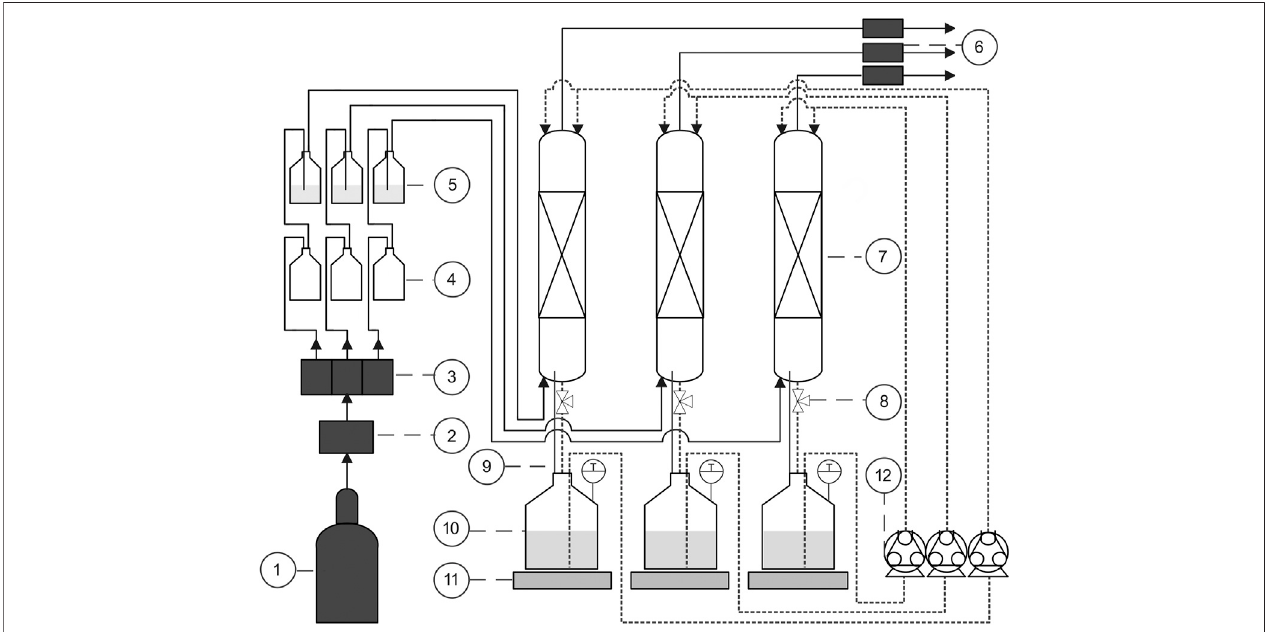
FIGURE 1 | Schematic drawing of three parallel TBs with gas cylinder (1), MFC (2), gas distributer (3), liquid traps (4), humidi fi cation fl asks (5), MGCs (6), three columns with heating jackets (7), sampling ports (8), pressure balancing tubes (9), three medium collection fl asks (10) which were located on magnetic stirrers (11) and contained magnetic stir bars, and peristaltic pumps